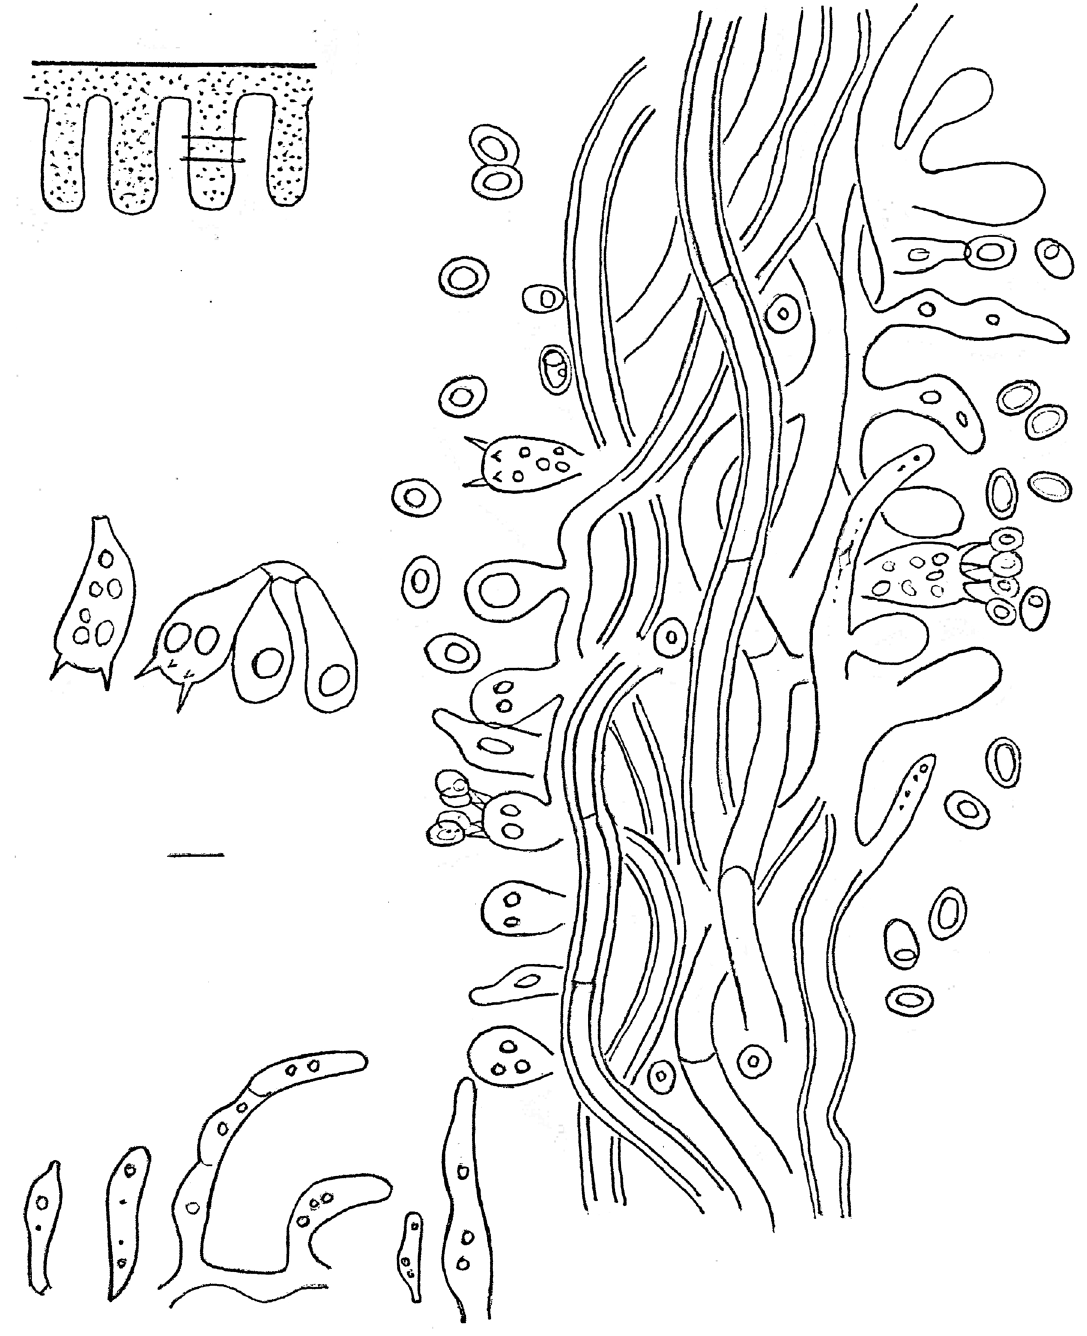
Figure 5. Line drawing of the hymenium of a pore of the type specimen of Phylloporia beninensis (OAB0511) showing the basidiospores, hyphae, basidia, basidioles, and cystidioles. Most elements with one or several guttulae. On the top left corner, we have the location where the microscopic preparation was taken. Scale bar = 5